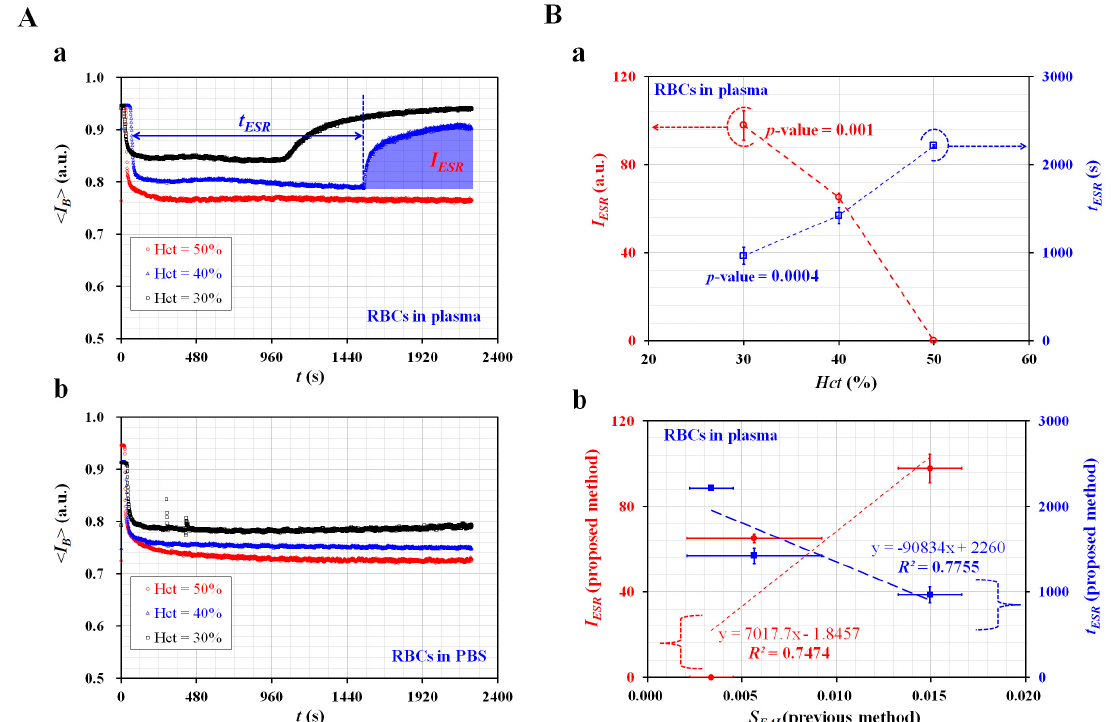
Figure 5. Evaluation of ESR for blood samples with respect to base solutions (1× PBS, and plasma) and hematocrit ( Hct = 30%, 40%, and 50%). ( A ) Variations of < I B > with respect to base solution and hematocrit. ( a ) Temporal variations of < I B > of blood sample (normal RBCs in plasma) with respect to